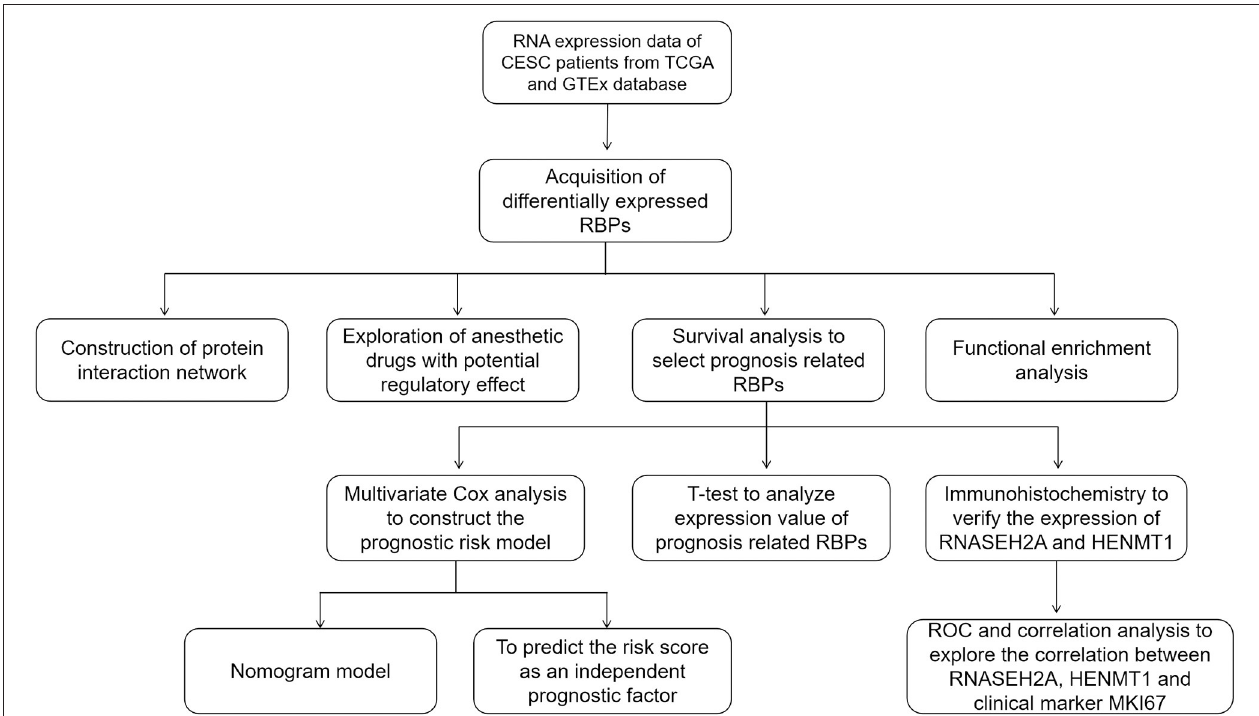
FIGURE 1 | The whole process of exploring potential regulatory anesthetic drugs based on RNA binding protein and constructing CESC prognosis